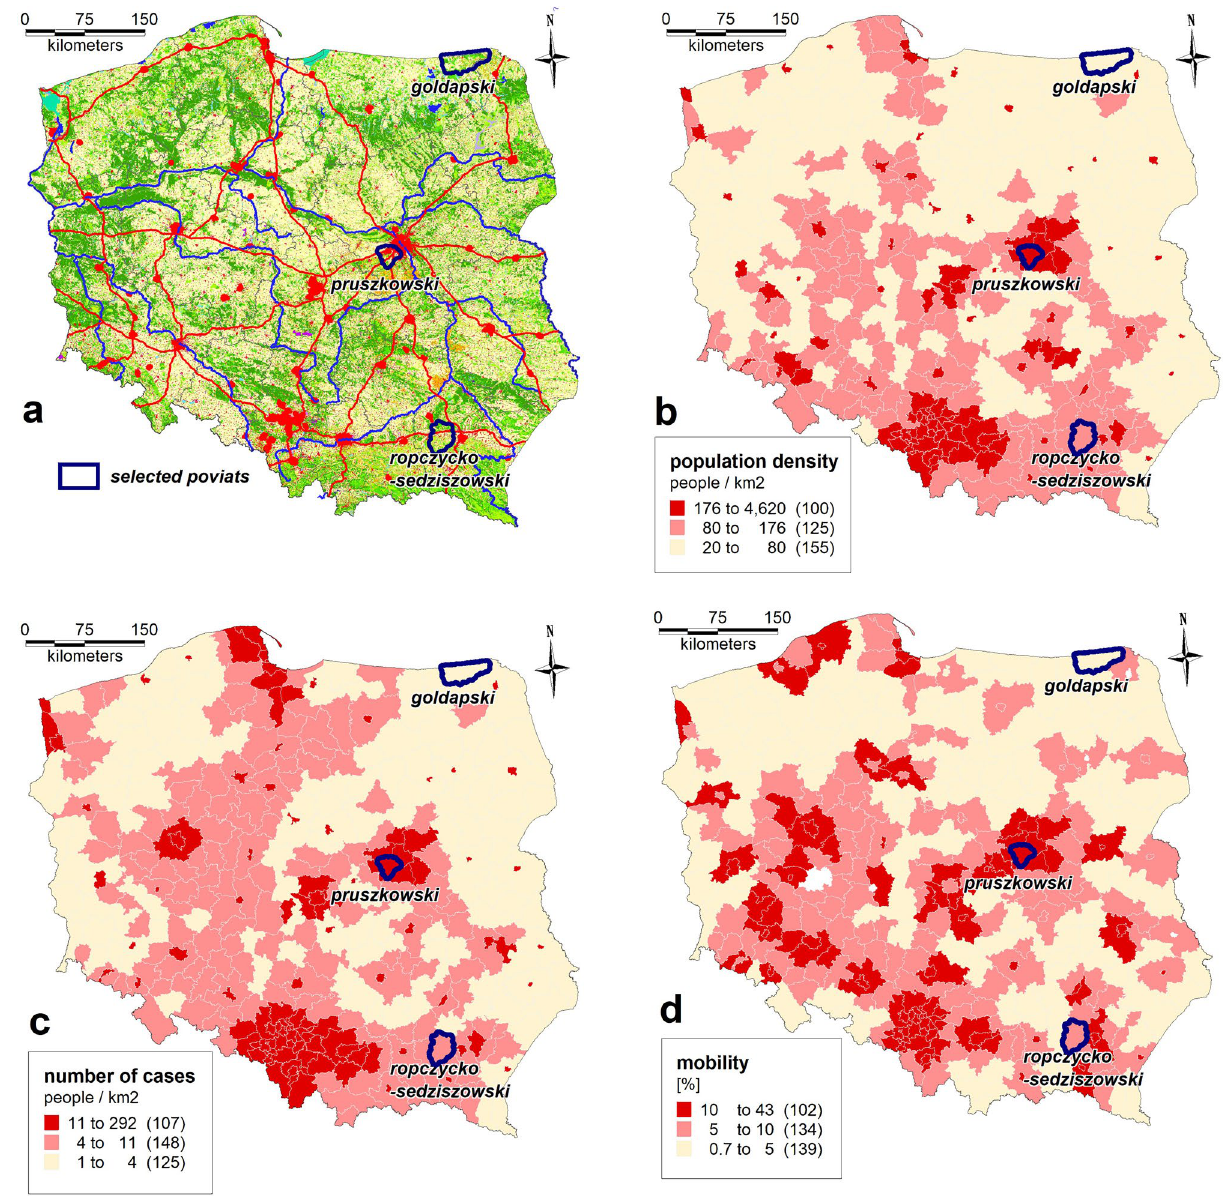
Figure 3. The set of selected criteria to choose the representative regions: ( a ) selected powiats, ( b ) population density, ( c ) number of cases/km 2 and ( d ) resident mobility (developed by the authors in QGIS ver.